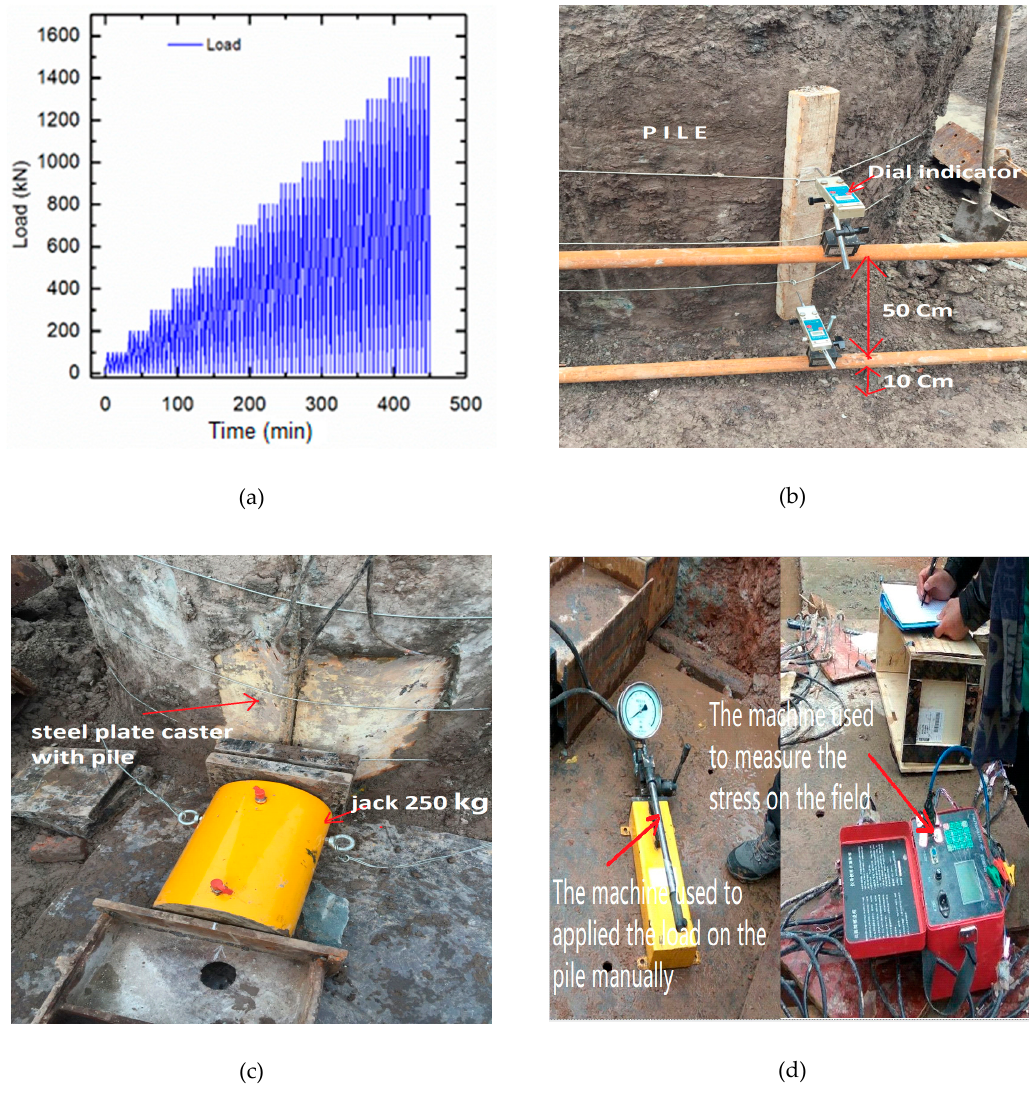
Figure 7. The material used on the field to the test; ( a ) The modeling of applying a load on the pile head; ( b ) The pile; ( c ) The view of the jack; ( d ) The machines used to apply load and measure the stress and strain.